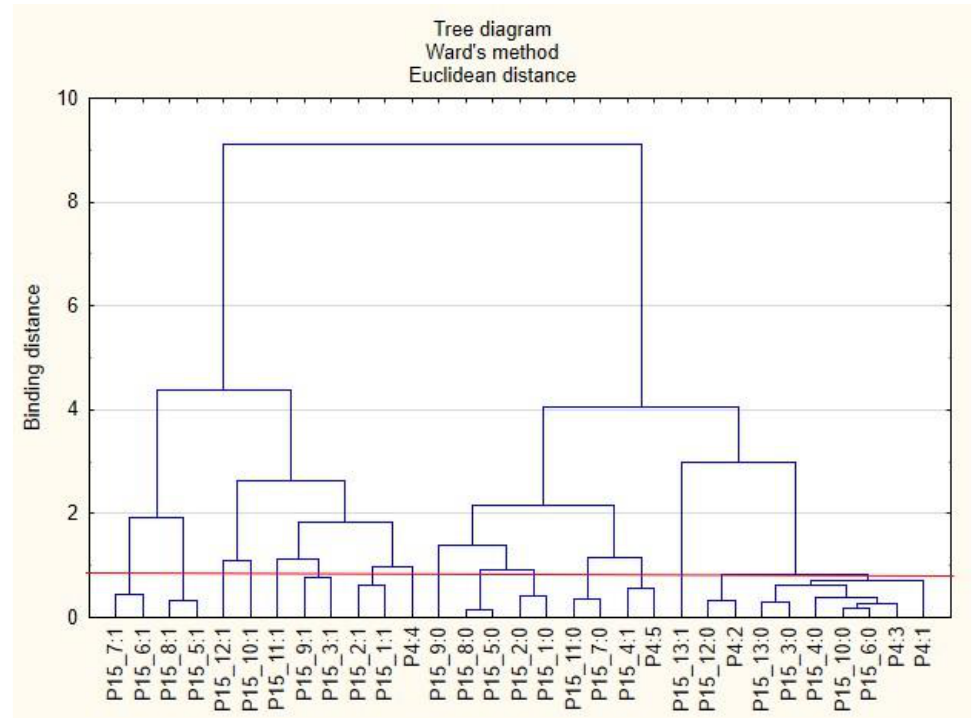
Figure 3. Diagram of hierarchical classification of variable categories: support received during the COVID-19 pandemic from the employer in the area of health care and effective use of the benefits offered (P15) as well as the amount of employment in the company (P4).